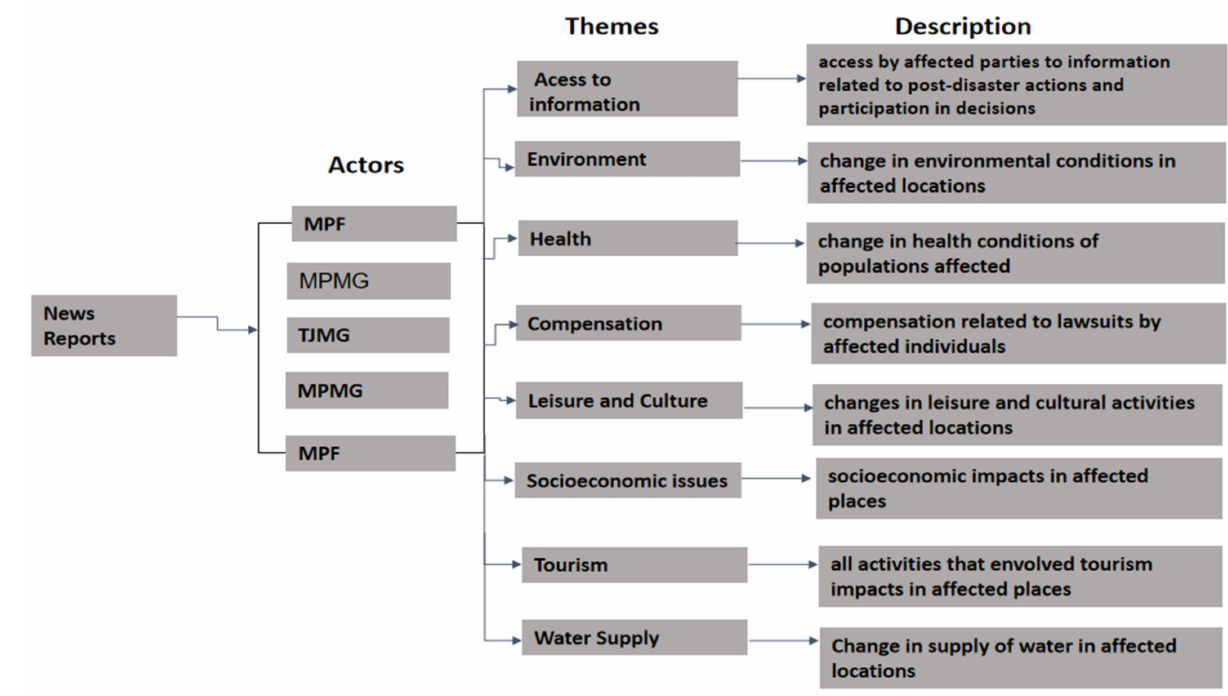
Figure 3. Schema of analysis protocol (source: